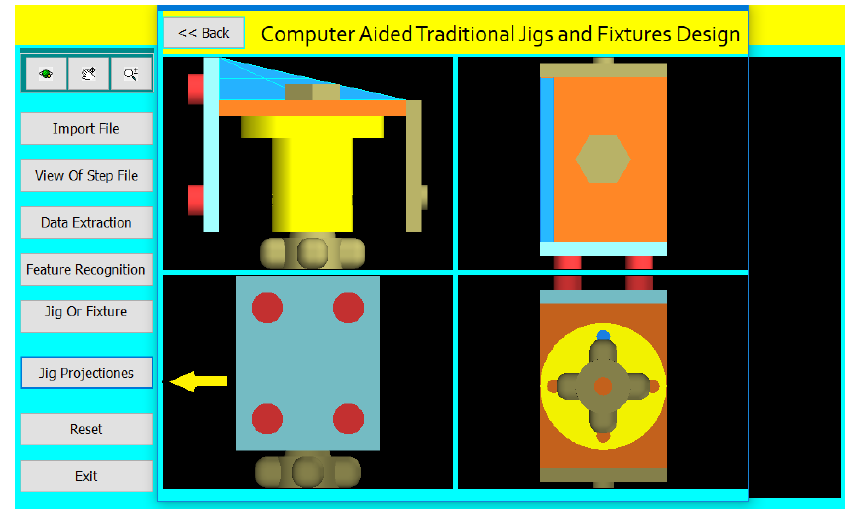
Figure 15. The sixth screen of the system interface.